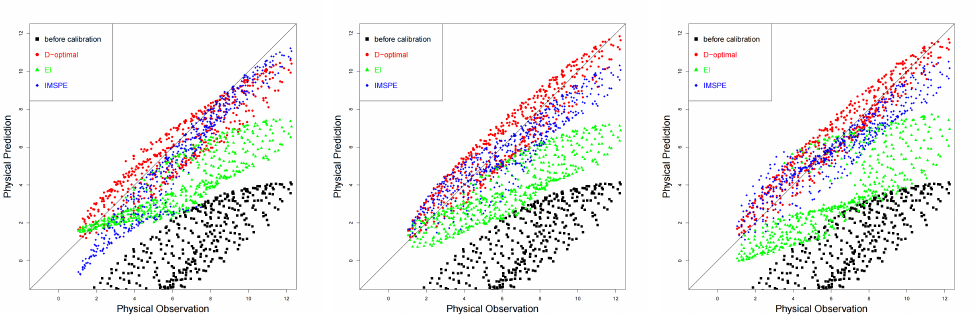
Figure 7. Physical predictions before and after calibration using the D-optimal method, EI method, and IMSPE method. The left, middle, and right panels show the results of sequentially adding 20, 25, and 40 points,